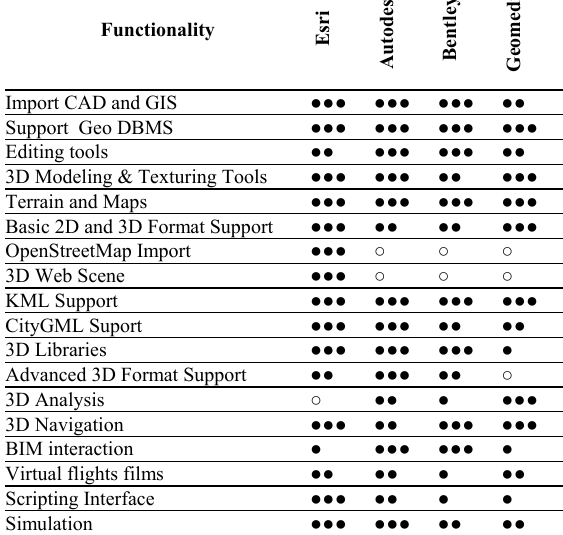
Table 1. Qualitative comparison of software functionality ( ○ : none, ● : bad, ●● : regular, ●●● : good)